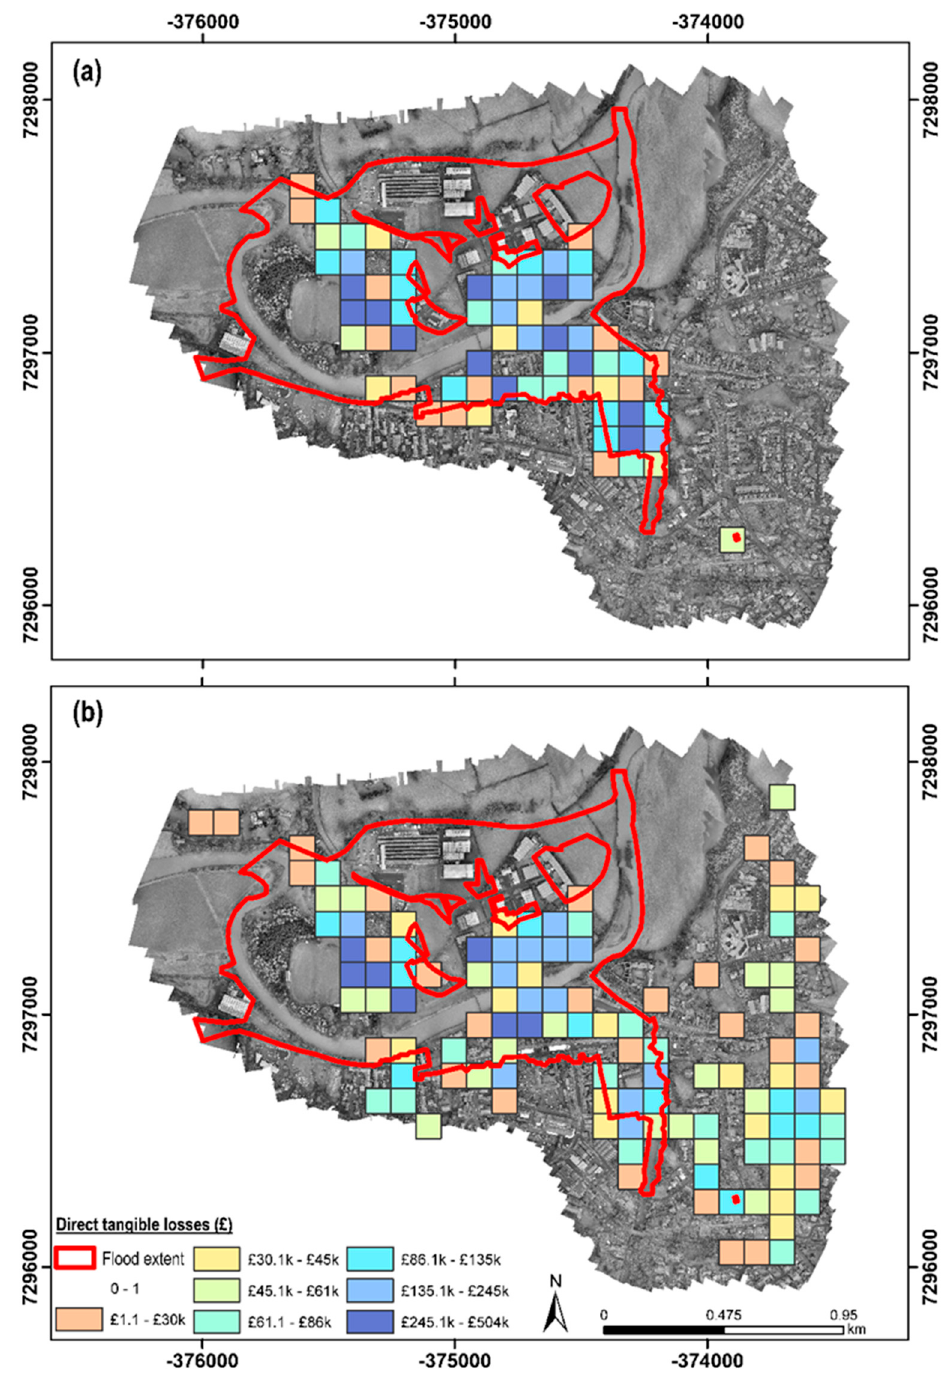
Figure 4. Estimated direct tangible losses (£) across Cockermouth following Desmond (5–6 December 2015) based on ( a ) the classic loss adjustment approach that relies on the Environment Agency fluvial flood extent and ( b ) the UAV loss adjustment approach. The methodology used for the estimation of the direct tangible losses was based on [31,32]. The losses (without VAT or other indirect taxes) are in GBP at 2016/17 prices. Calculations assume no resilient/resistance measures were in place.